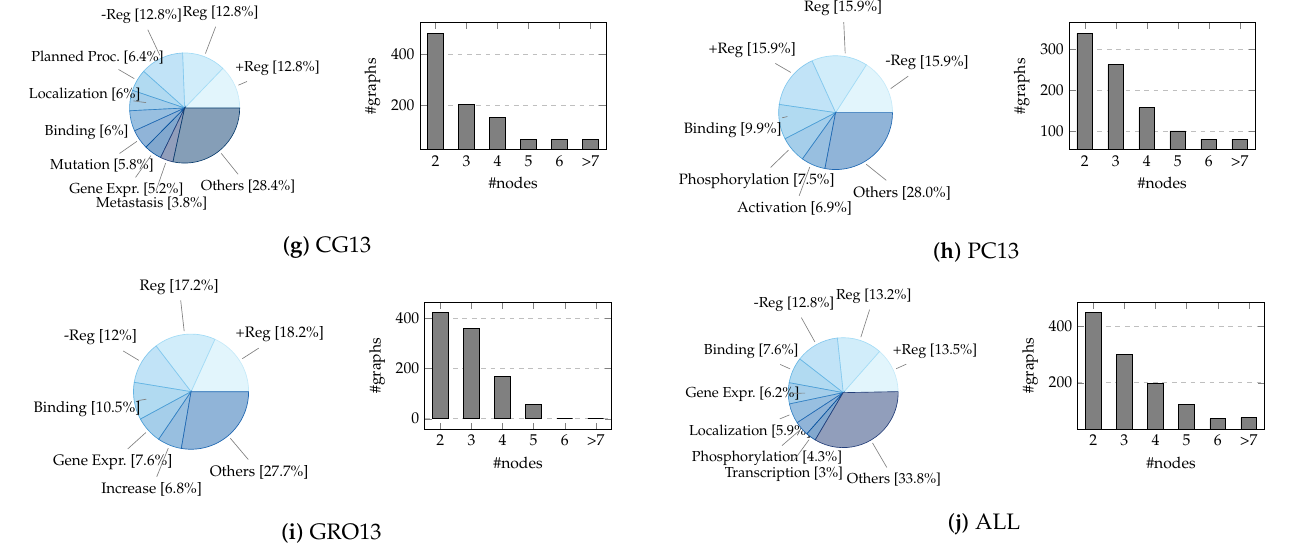
Figure 1. Distribution of event types (root ones, in case of nesting) and graph sizes within sampled datasets.